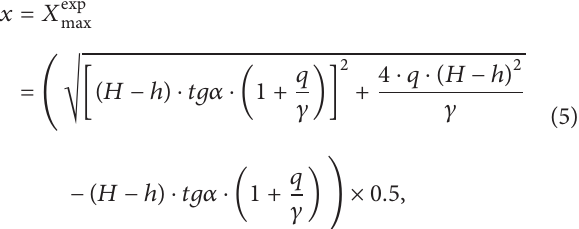
Figure 5: Power density evaluated based on ICS Telecom simula- tions. The simulated maximum exposure point is located at 75 m, same as estimated for 𝛾 = 2 and higher than estimated for 𝛾 = 2.6